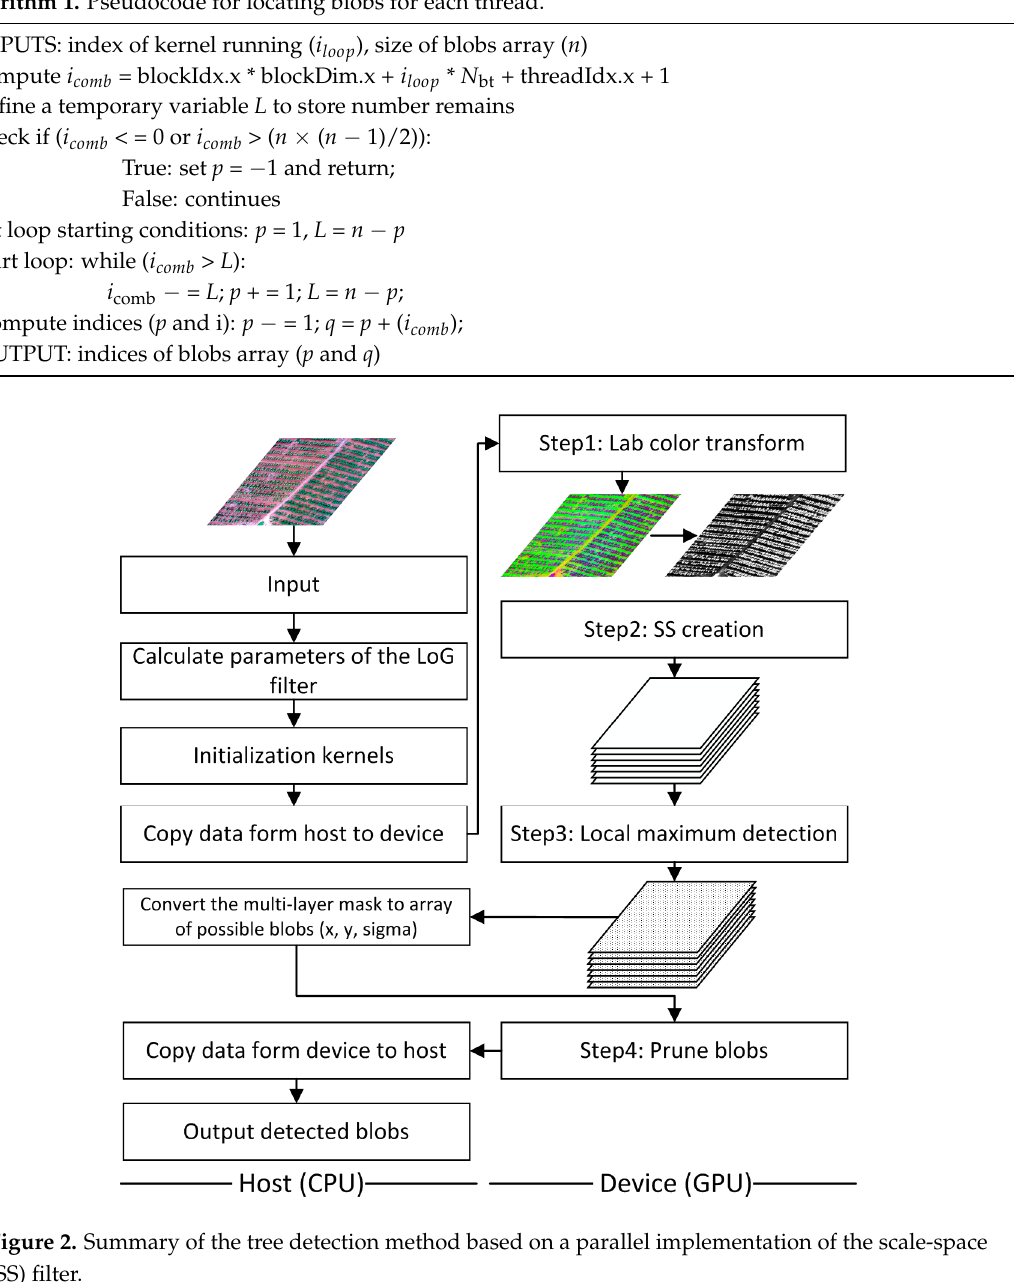
Algorithm 1. Pseudocode for locating blobs for each thread.